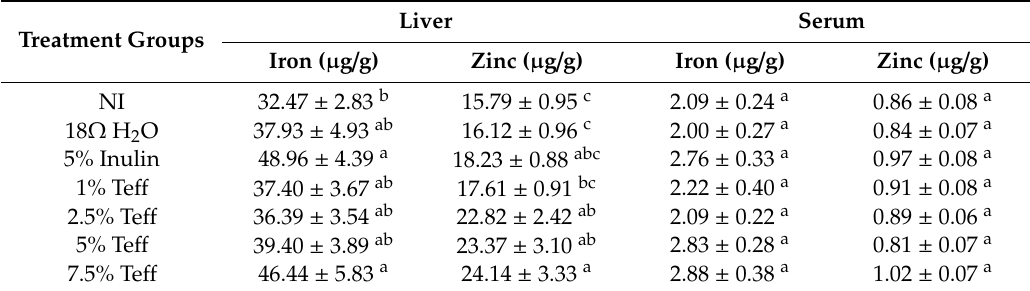
Table 6. Fe and Zn concentrations in liver and serum 1